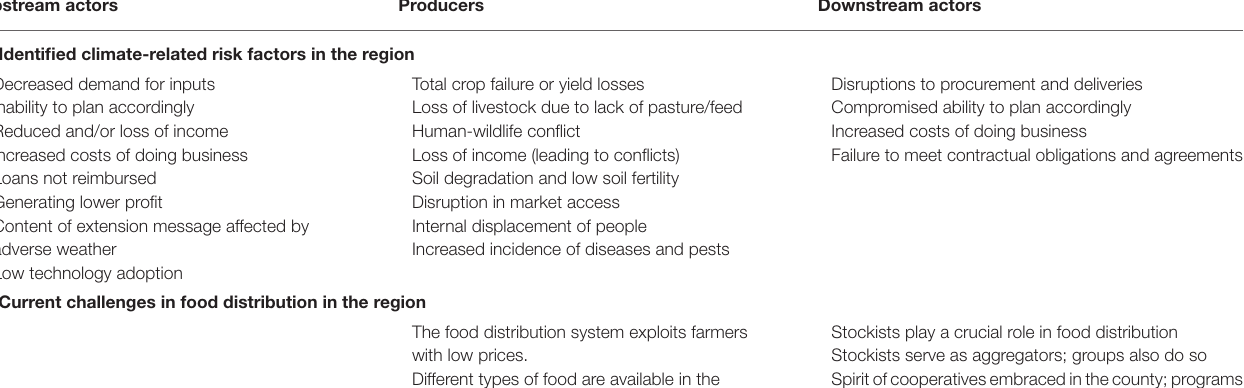
TABLE 5 | Major climate-related risk factors in food value chain (FVC) segments: producers/farmers, upstream actors (suppliers and service providers), and downstream actors (brokers, intermediaries, stockists, processors, and exporters), current food distribution challenges, and suggested ways to improve the FVC. Upstream